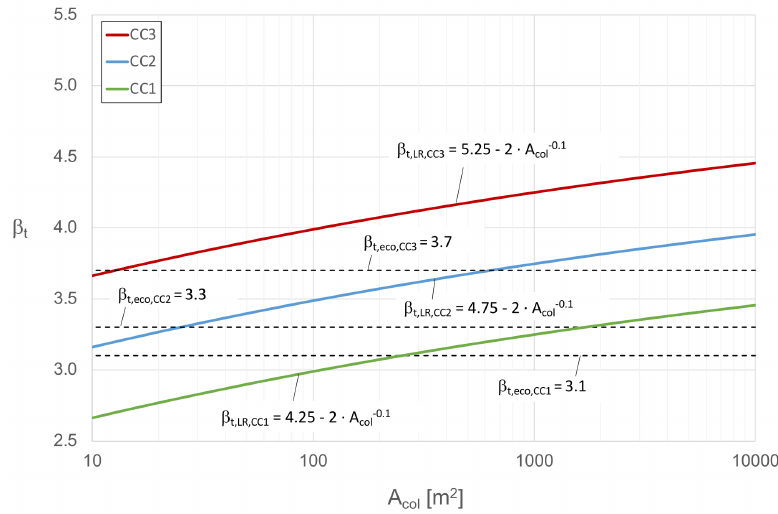
Figure 4. Annual reliability requirements for human safety, β the consequence class, CC [5], recommended for the assessment of existing structures; β t,eco [19]: tentative target reliabilities based on economic optimization for large relative cost of safety measures and different consequence classes,